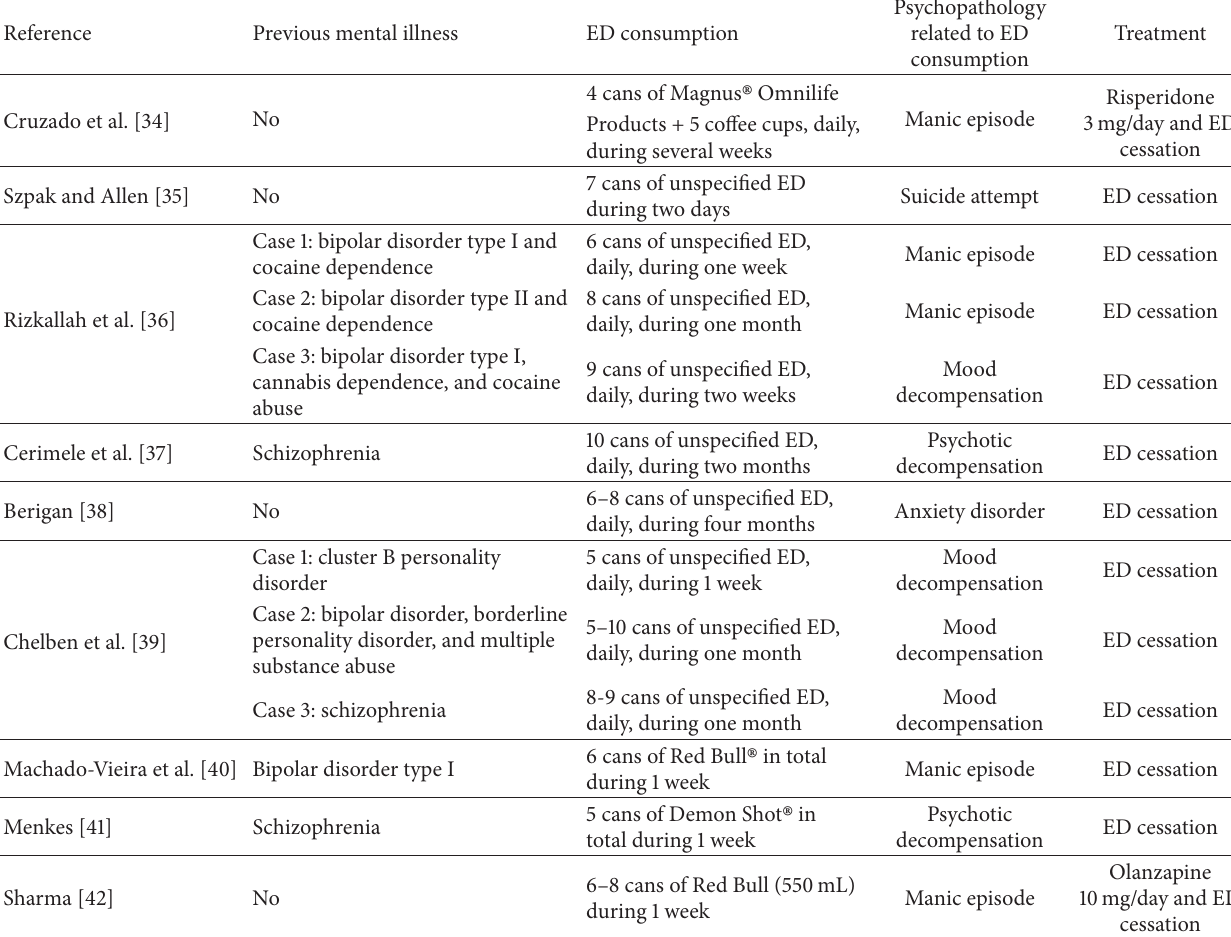
Table 2: Case reports published about psychopathology related to ED